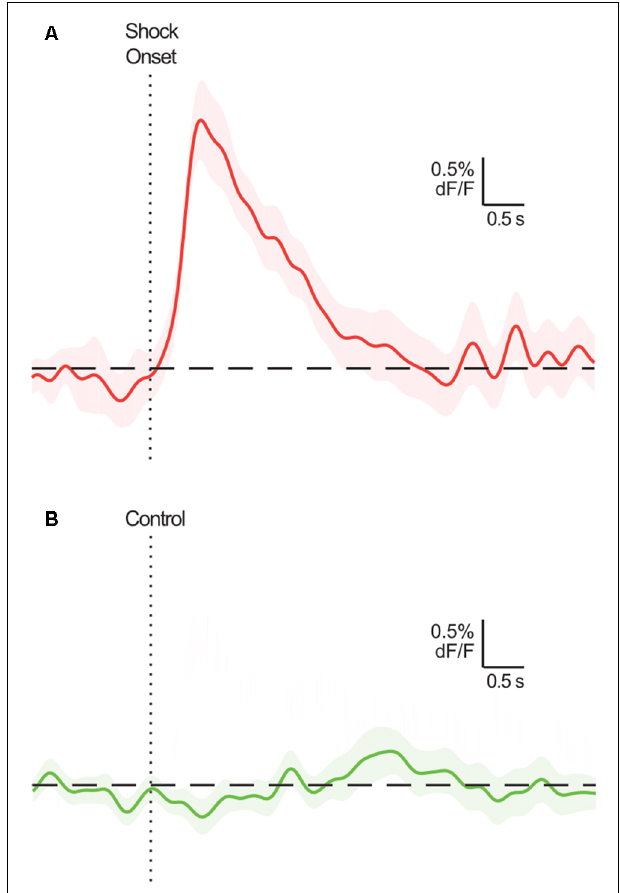
FIGURE 1 | Example event-related calcium transients in BLA principal neurons (mean ± SEM; adapted from Sengupta et al., 2018; Figure 1C). These neurons exhibit a characteristic excitatory transient following shock delivery (A) , but not during a comparable period where the shock is not delivered (B) . Assuming the true response of these neurons is, in fact, excitatory for (A) and null for (B) , it would be optimal for statistical analyses to identify a significant excitatory transient at relevant time points in (A) , and no significant transients across the time points in (B)